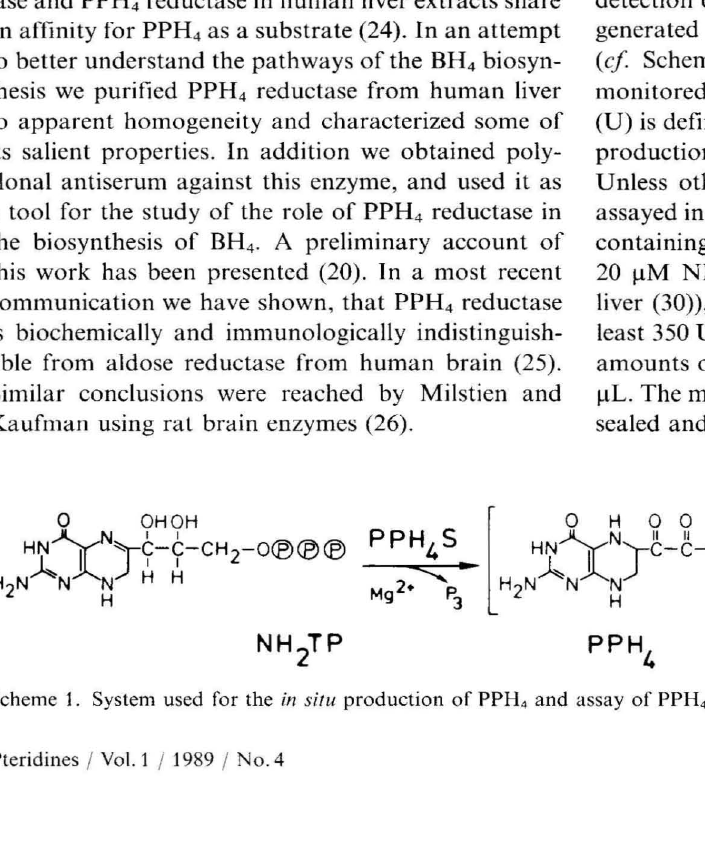
and assay of PPH reductase 4 4